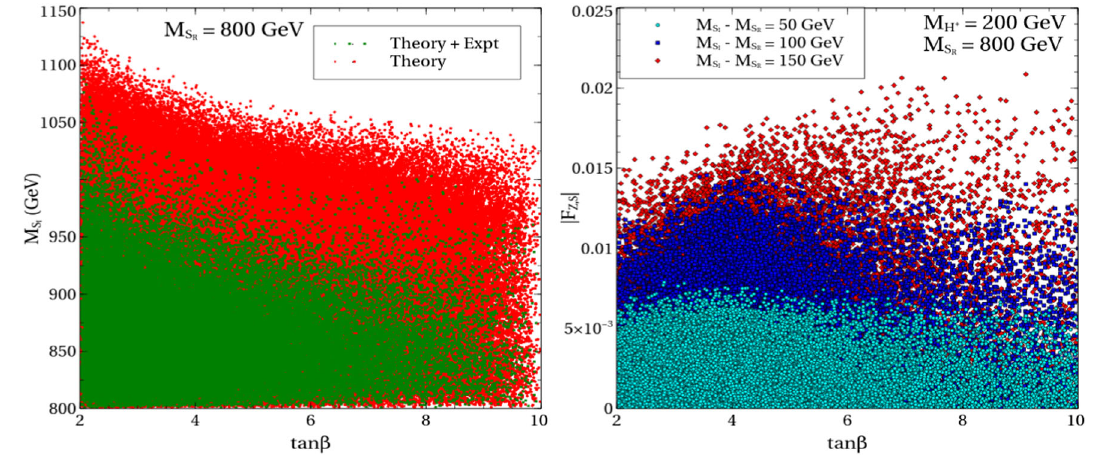
− M = S R I ) = ( 200GeV , 800GeV R